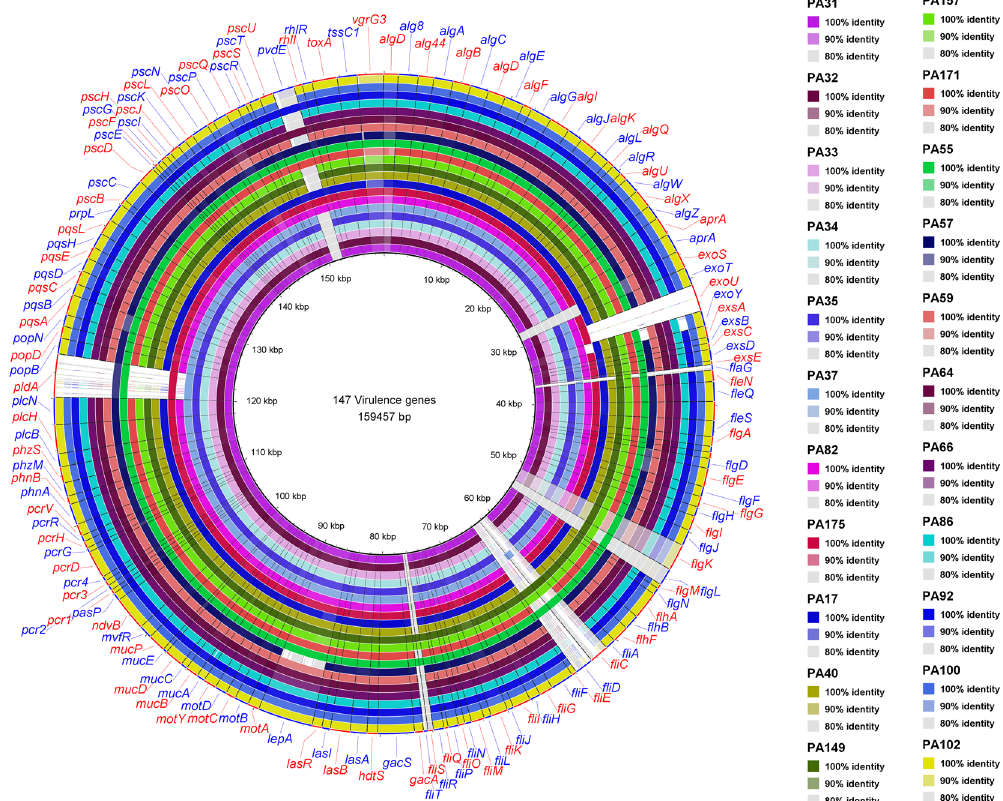
Figure 4. A circular representation of the genomes of studied isolates. The draft genomes of 22 strains were aligned against the 147 virulence genes curated from VFDB. Each genome is represented by a ring with different colours, which are shown in figure. Image was generated using BRIG (http://brig.sourceforge.net).